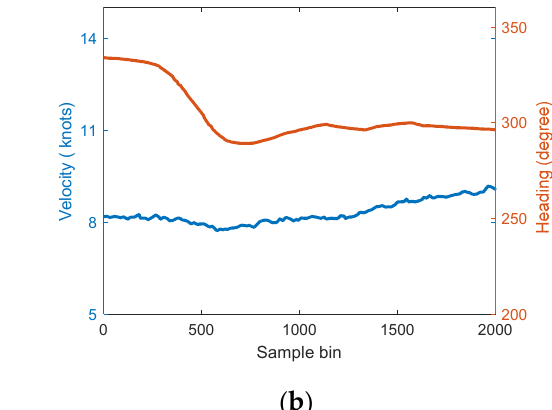
target RD spectrum are shown in Figure